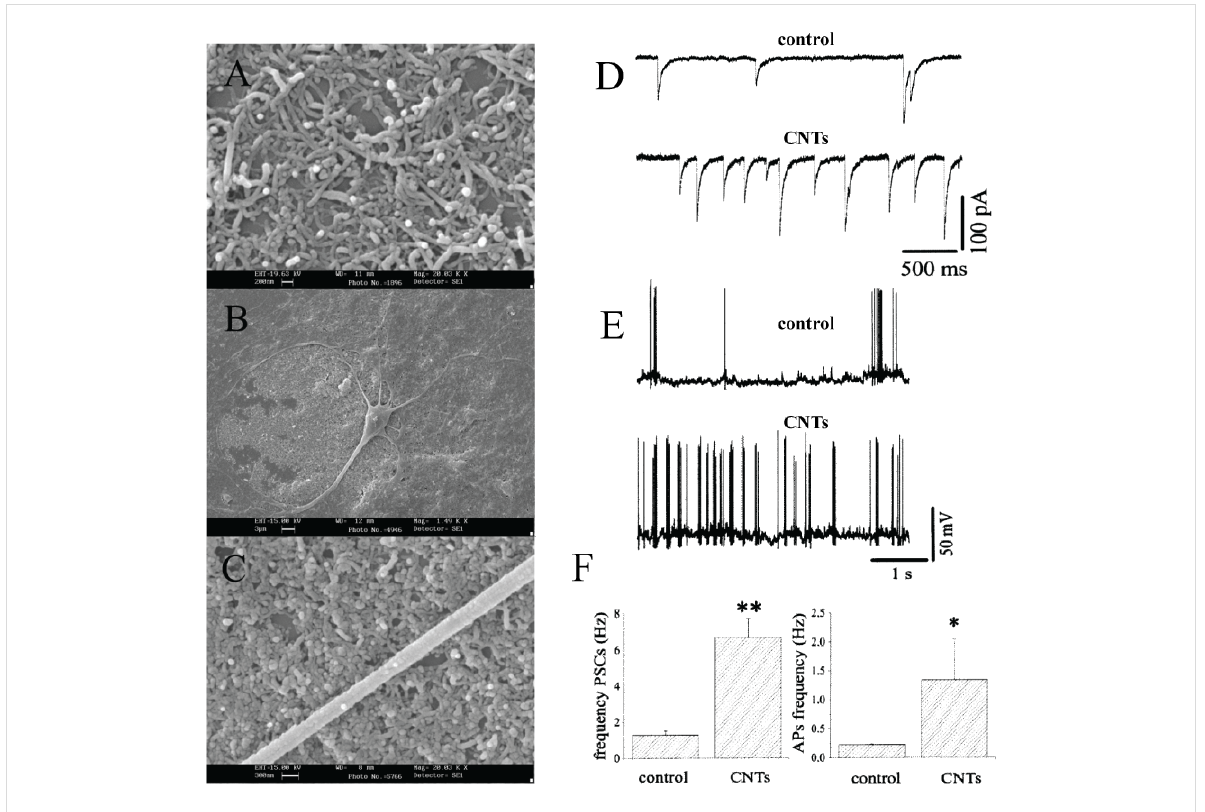
Figure 2: CNTs thin-films are optimal substrates for neuronal growth and development ex vivo (A–C) and improve spontaneous synaptic activity , as shown by the increased frequency of (D) post-synaptic currents and of (E) action potentials. Reproduced and modified from [118] with permission. Copyright 2005 American Chemical